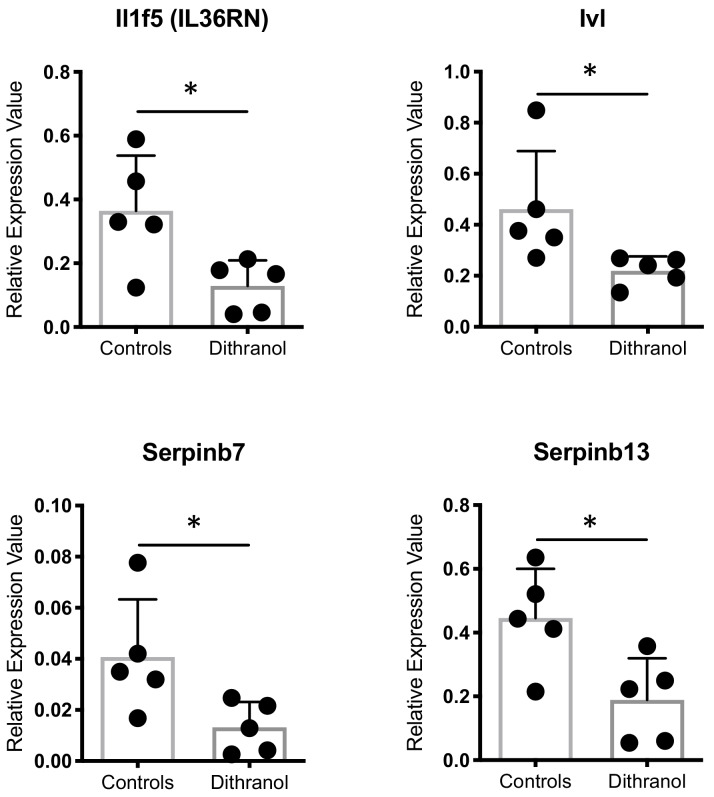
Verification of microarray gene expression analysis: Gene expression analysis by RT-PCR of selected genes based on microarray data in dithranol-treated c-Jun/JunB knockout mice vs. vehicle-treated controls.Bars represent mean ± SD (n = 5) of relative expression values (deltaCT) normalized to Ywhaz. Unpaired t-test was used for statistics. Il1f5 (IL36RN), interleukin 1 family member 5 (IL-36 receptor antagonist); Ivl, Involucrin; Serpinb7, Serine peptidase inhibitor, clade B member 7; Serpinb13, Serine peptidase inhibitor, clade B member 13.